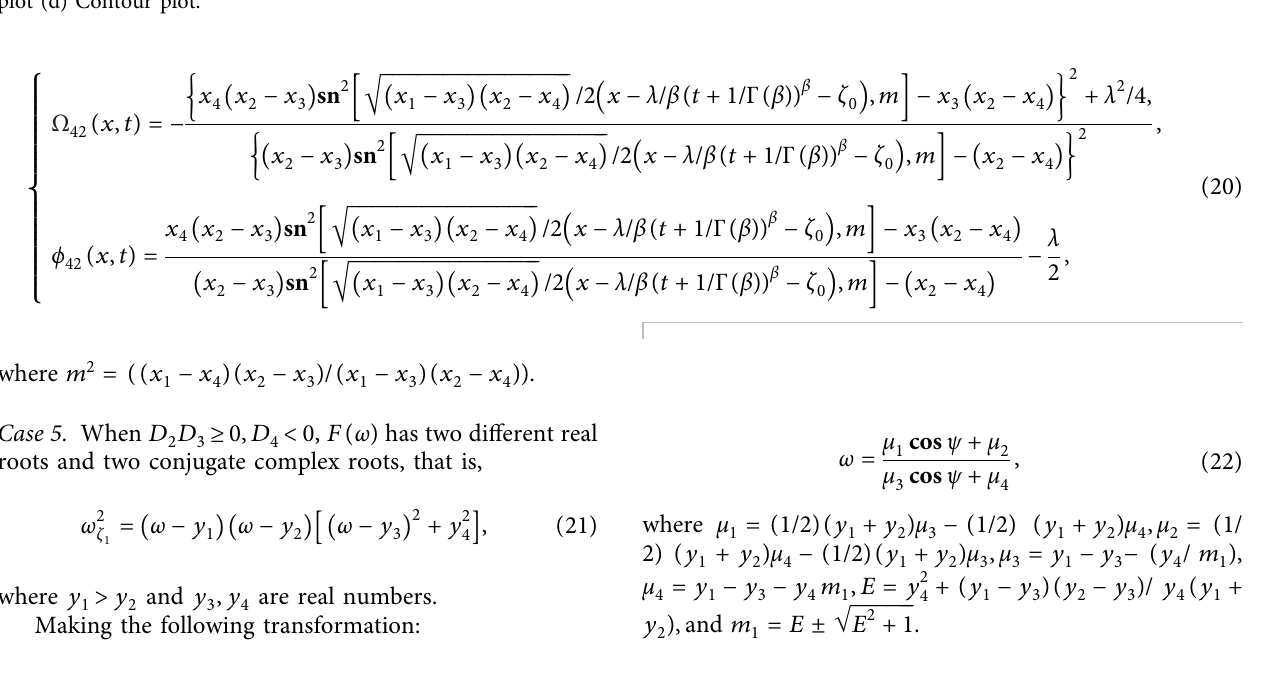
( x, t ) in equation (15) at a 2